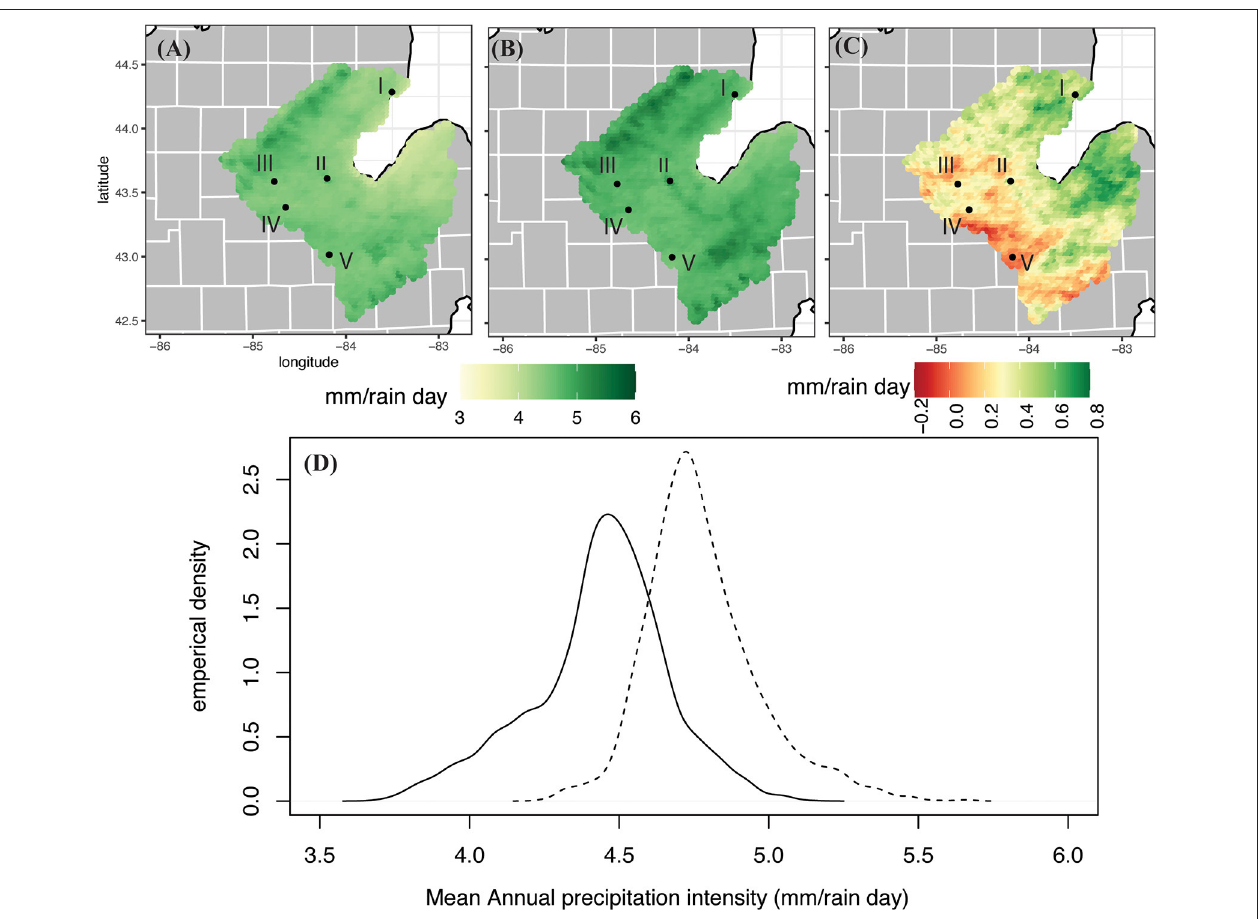
FIGURE 7 | Same as Figure 2 , but for mean annual precipitation intensity.